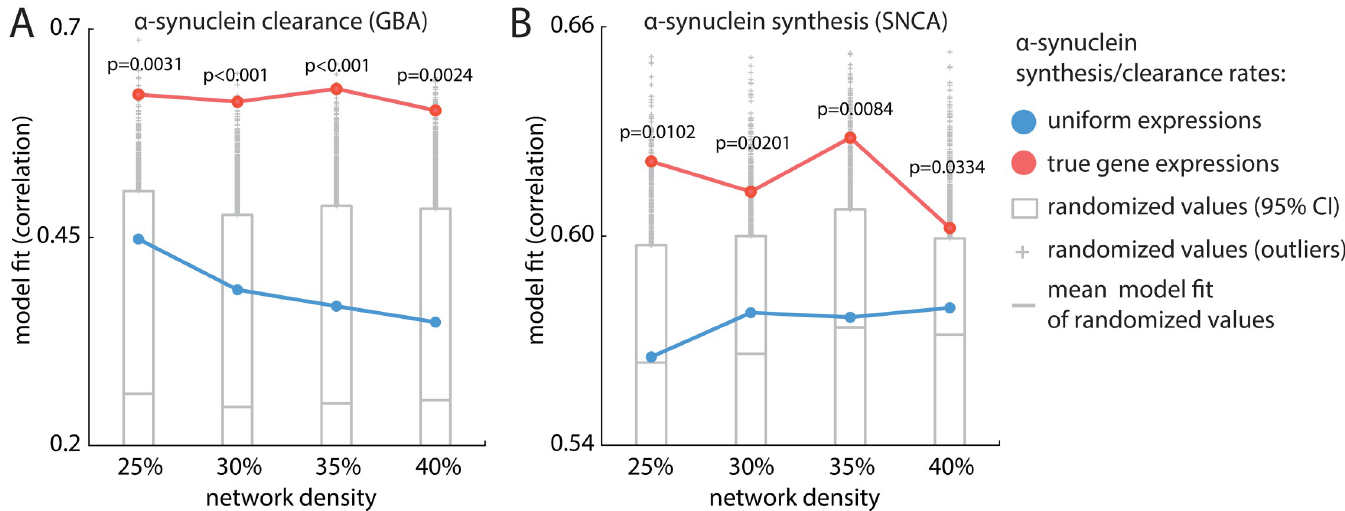
Fig 6. Assessing the contribution of GBA and SNCA gene expression. To assess the influence of gene expression on atrophy, model fit using real expression values (red) is compared to null models in which node-wise expression profiles of GBA and SNCA (reflecting, respectively, α -synuclein clearance and synthesis) were shuffled. Both manipulations significantly reduce model fit regardless of network density. (A) Model fit of randomized GBA expression (gray bar) is significantly worse than that of the real GBA expression (red line). p 25% = 0.0031, p 30% < 0.001, p 35% < 0.001, p 40% < 0.0024. (B) Model fit of randomized SNCA expression (gray) is significantly worse than that of the real SNCA expression (red). p 25% = 0.0102, p 30% = 0.0201, p 35% = 0.0084, p 40% = 0.0334). Notably, uniform transcription profiles, in which all nodes have identical expression values (blue line), yield above-chance model fit but perform poorly compared to the model with real expression values ( GBA uniform correlations: r 25% = 0.4479, r 30% = 0.3869, r 35% = 0.3672, r 40% = 0.3481; SNCA uniform correlations: r 25% = 0.5653, r 30% = 0.5780, r 35% = 0.5767, r 40% = 0.5794). The underlying data can be found at https://github.com/yingqiuz/SIR_simulator/blob/master/results/Fig6.mat. GBA, glucocerebrosidase gene; SNCA, α -synuclein